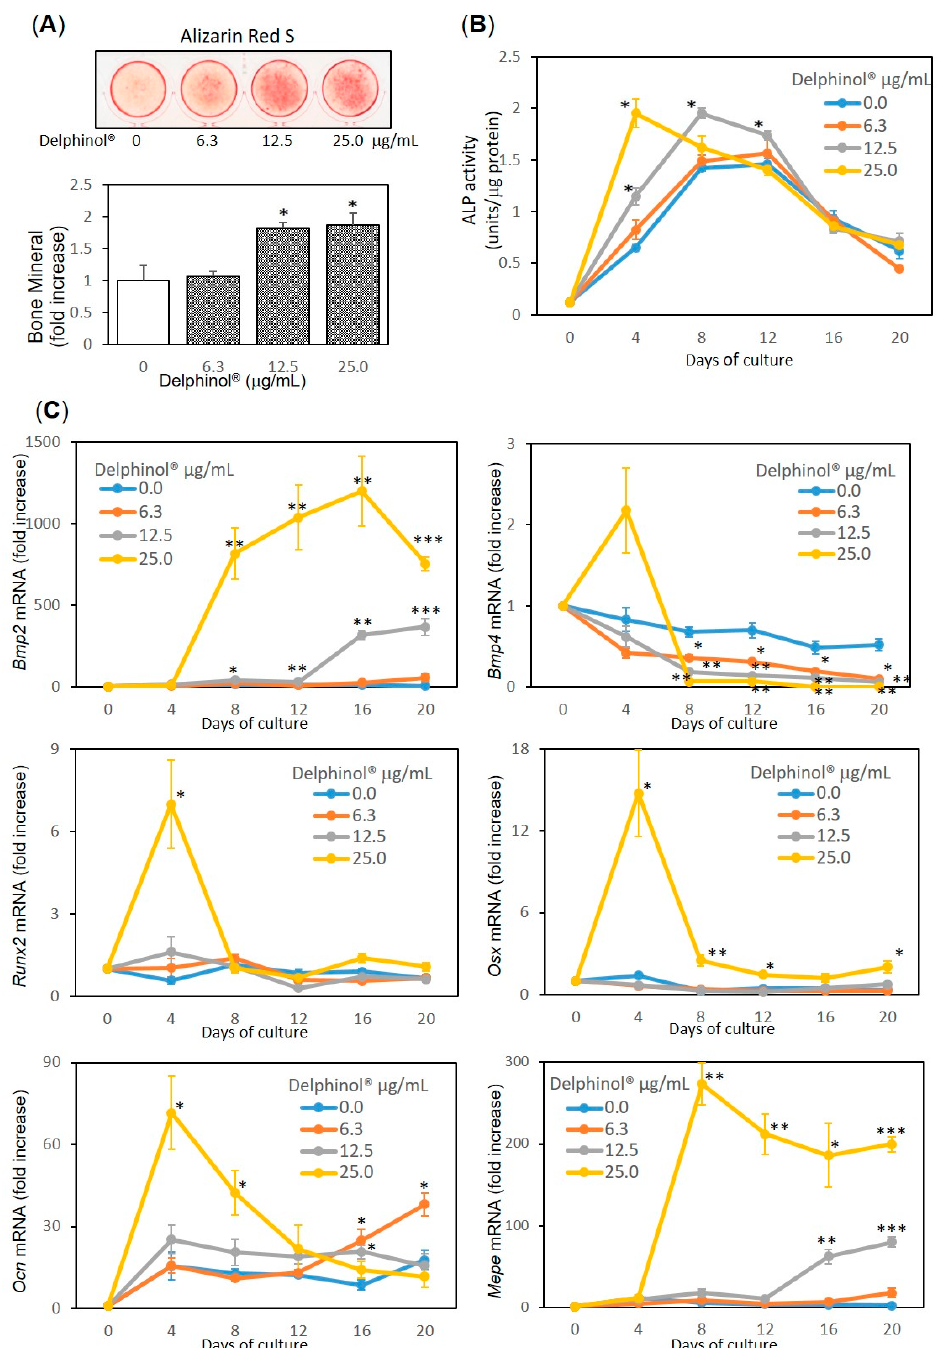
Figure 1. Stimulatory e ff ects of Delphinol ® on osteoblastogenesis. ( A ) Mineralization of MC3T3-E1 cells. Confluent culture was incubated with Delphinol ® at indicated concentrations for 16 days. At the end of incubation, cells were washed then fixed with 70% ethanol, and stained with Alizarin red S. ( B ) Alkaline phosphatase (ALP) activity of MC3T3-E1 cells. Confluent culture was treated with Delphinol ® . At the end of incubation,. ALP activity was measured in the cell lysate. ( C ) Expression of osteoblast (OB) differentiation-related genes in MC3T3-E1 cells. Confluent culture was treated with or without Delphinol ® . At the end of incubation, total RNA was extracted, reverse-transcribed, and used for qPCR. Values are expressed as mean ± SEM ( n = 3–4). * p < 0.05, ** p < 0.01, *** p <